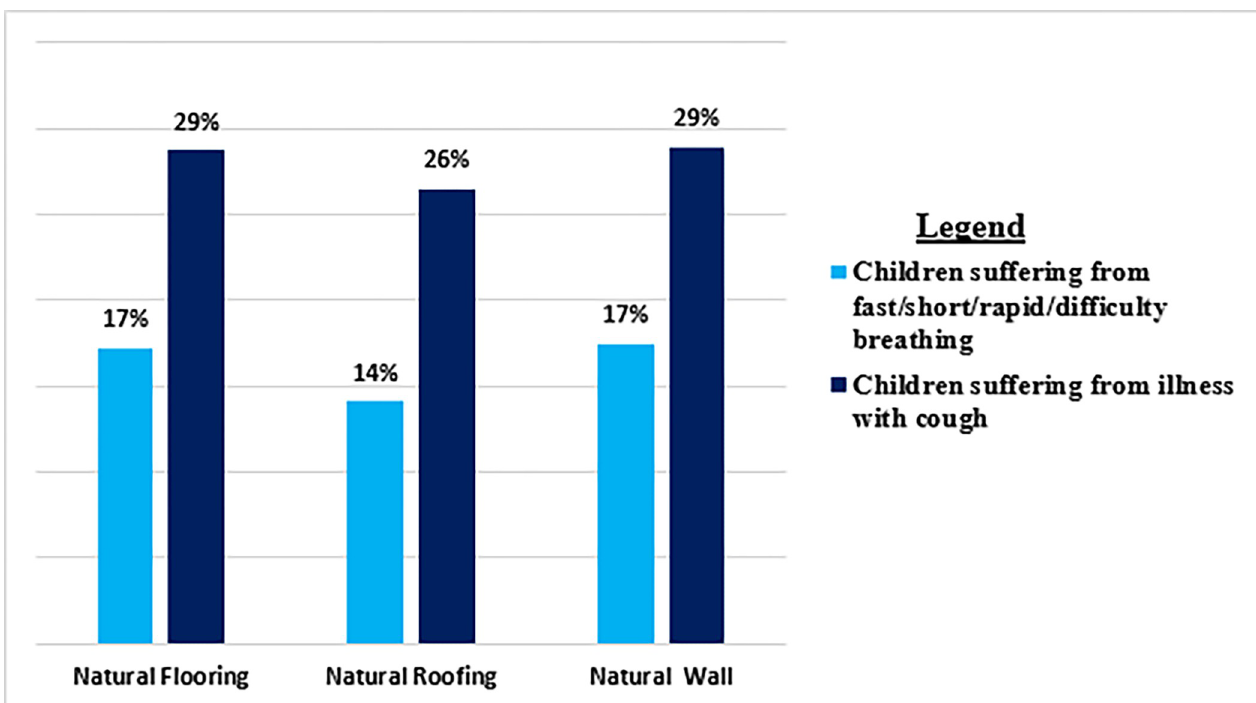
Fig 3. Poor housing quality and Percentage of children suffering from ARI symptoms in Punjab, Pakistan (MICS